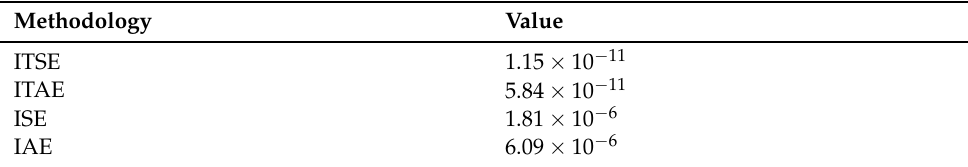
Table 4. Minimization results for the current